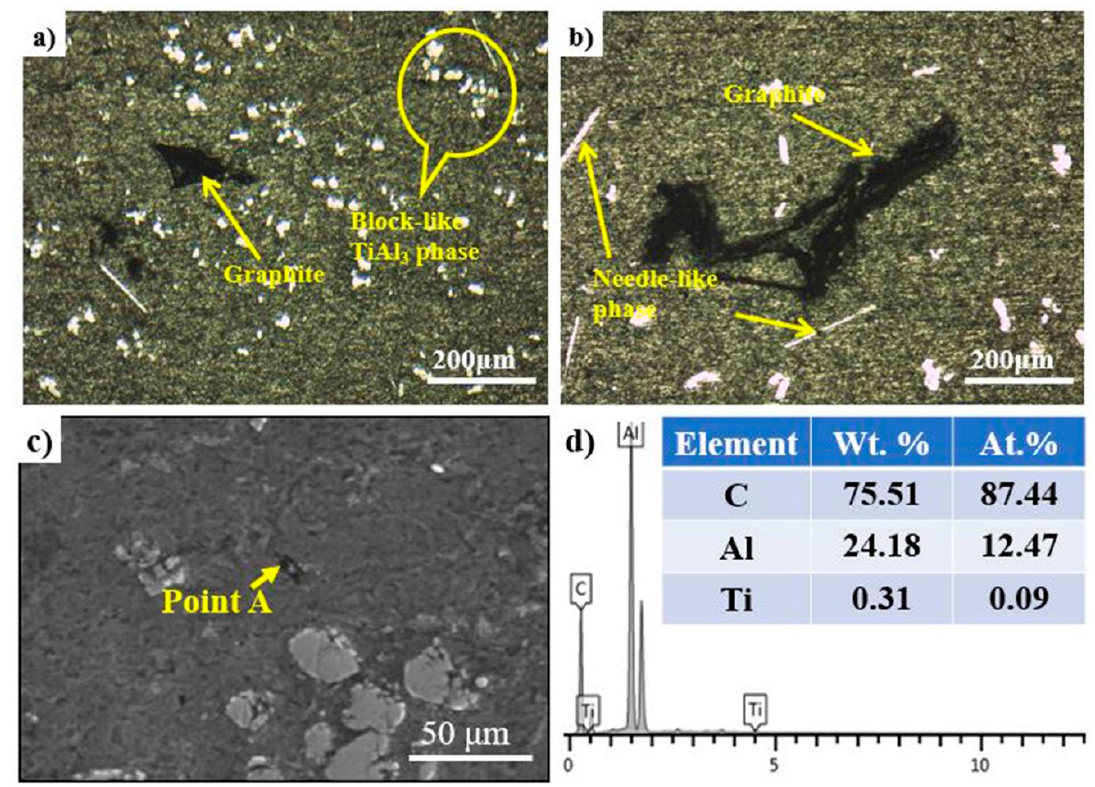
Figure 3. The undissolved graphite of the FW-1 and FW-2 master alloys at 60 min and 1273 K: ( a ) FW-1; ( b ) FW-2; ( c ) a secondary electron image of the undissolved graphite in FW-1; and ( d ) the EDS analysis of point A marked in ( c ).